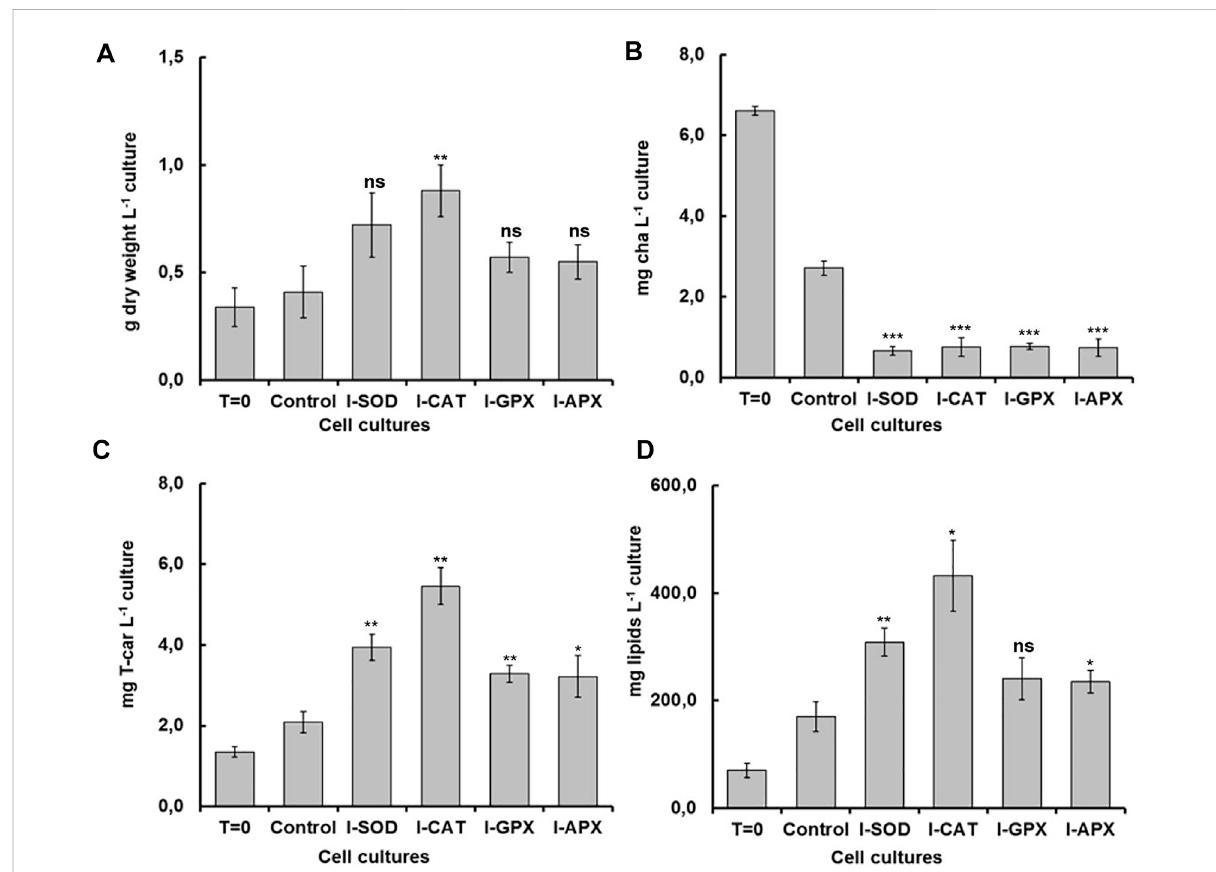
FIGURE 2 Comparison of dry weight, chla, T-car and lipid concentrations at inoculation (T = 0) and termination (day 9) during the carotenogenesis process forall cultures. (A) isdryweightconcentration ing L − 1 ofculture. (B) ischlorophyllconcentration inmg L − 1 ofculture. (C) is